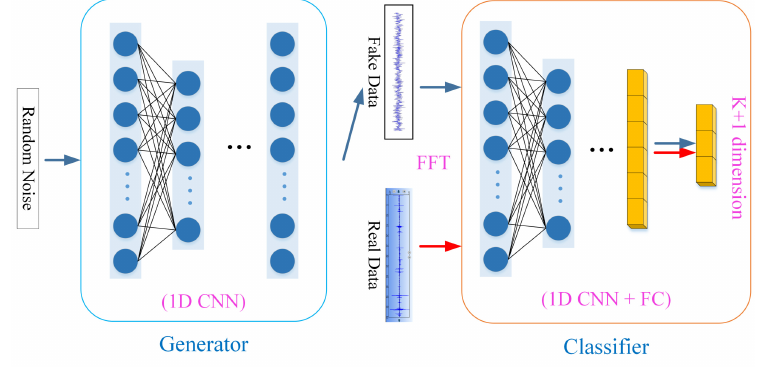
Figure 8. Network structure